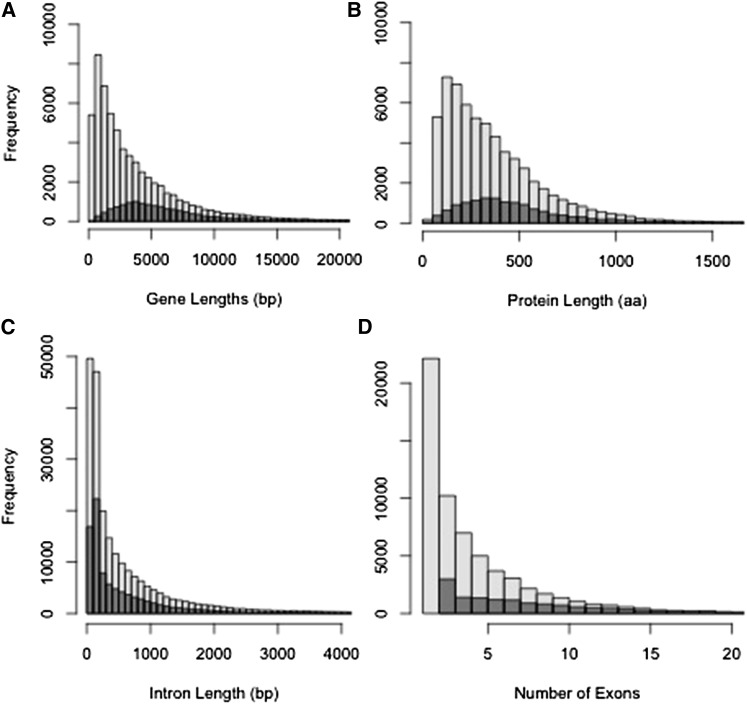
Frequency distribution results of Maker annotation of the Q. lobata v1.0 genome. (A) Transcript lengths. (B) Protein lengths. (C) Intron lengths. (D) Number of exons. Light gray bars represent all 61,773 gene models. Dark gray bars represent the high confidence subset of 13,898 models.